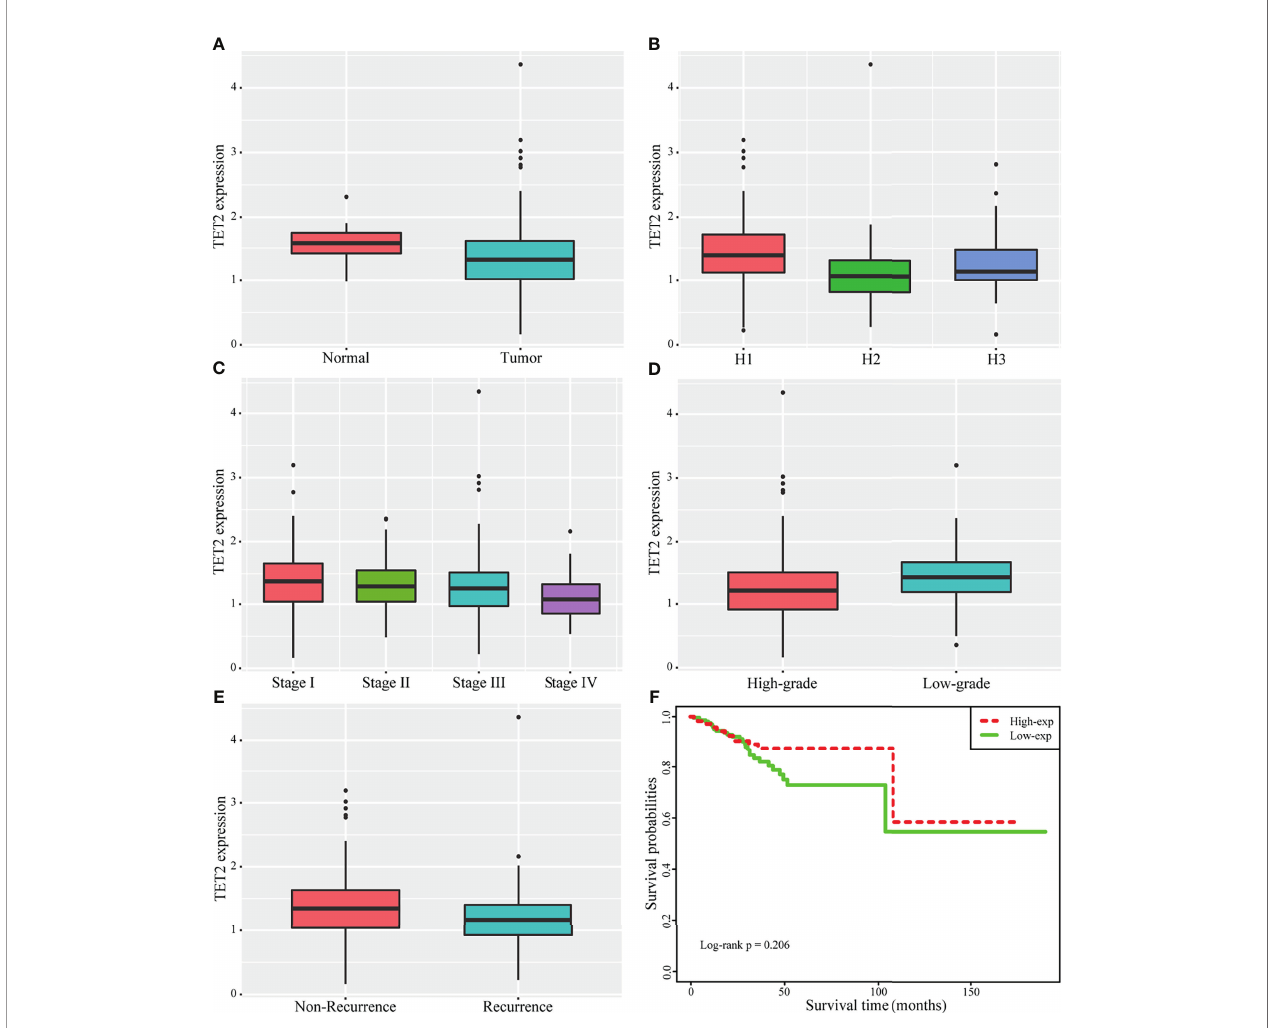
FIGURE 1 | Clinical signi fi cance of expression of TET2 in endometrial cancer from TCGA public database. The signi fi cant differences of TET2 expression between normal and endometrial cancer (A) . TET2 expression was also signi fi cantly different among different histopathological samples (1 stands for Endometrioid endometrial adenocarcinoma, 2 stands for Serous endometrial adenocarcinoma, 3 stands for Mixed serous and endometrioid) (B) . With the increase of stage, TET2 expression was continuously down-regulated (C: 1 stands for Stage I, 2 stands for Stage II, 3 stands for Stage III, 4 stands for Stage IV). TET2 was signi fi cantly down-regulated in the high-grade group (D) . TET2 was signi fi cantly lower in patients with recurrence (E) . TET2 expression is a protective factor, and the high expression group tends to have a better prognosis (F)